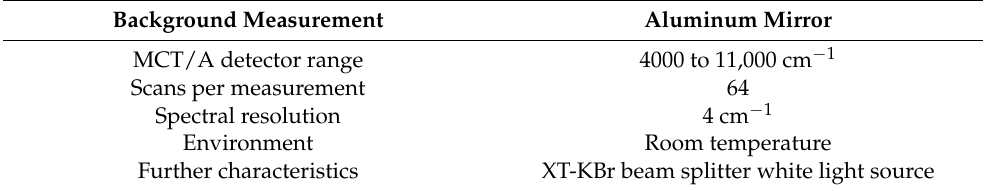
Table 2. Settings for DRIFTS analysis.